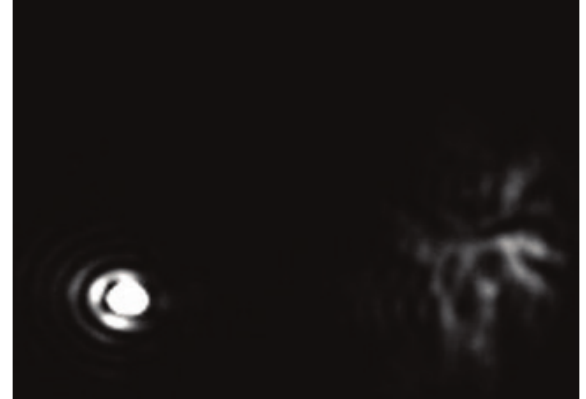
Fig. 4. Captured image of the formed SrS particles (surrounded by a series of diffraction rings) in MilliQ water in the NTA video